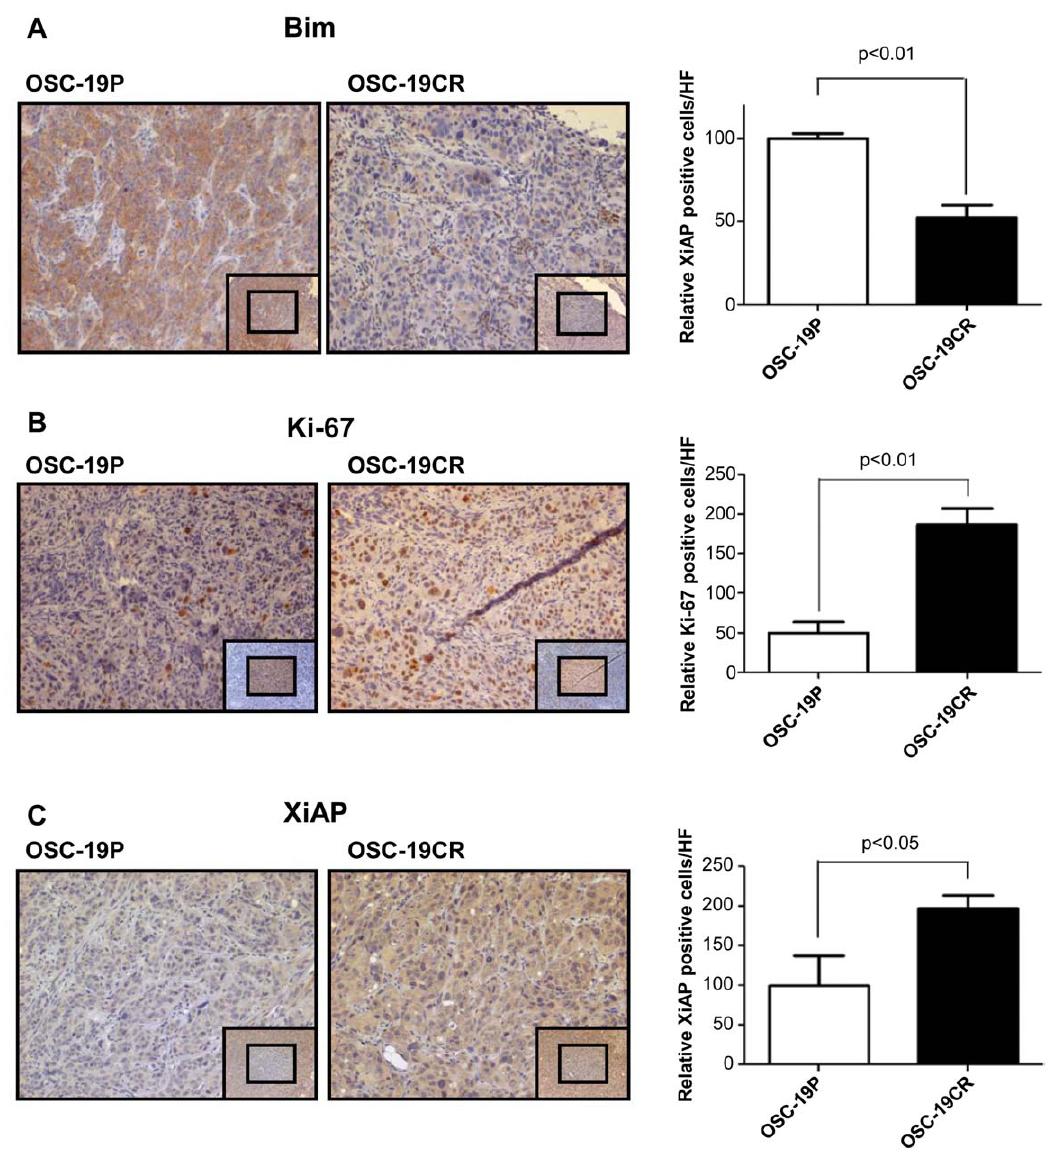
Figure 7. Immunohistochemistry staining of mouse tumor tissue originated from OSC-19P and OSC-19CR. A. Immunohistochemistry staining of OSC-19P (left) and OSC-19CR (right) with Bim. B. IHC staining of OSC-19P (left) and OSC-19CR (right) with Ki-67. The pictures were taken at 100 6 magnification, the inlet at 50 6 magnification. (C) IHC staining of OSC-19P (left) and OSC-19CR (right) with XiAP.